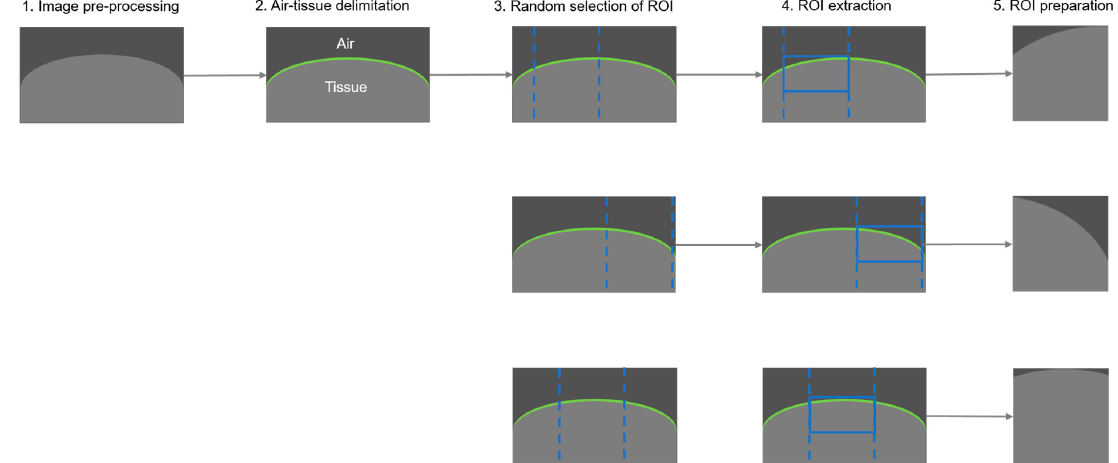
Figure 3. Proposed image data preparation methodology. 1. Image pre-processing, 2. air-tissue delimitation, 3. random selection of region of interest (ROI), 4. ROI extraction, and 5. ROI preparation.